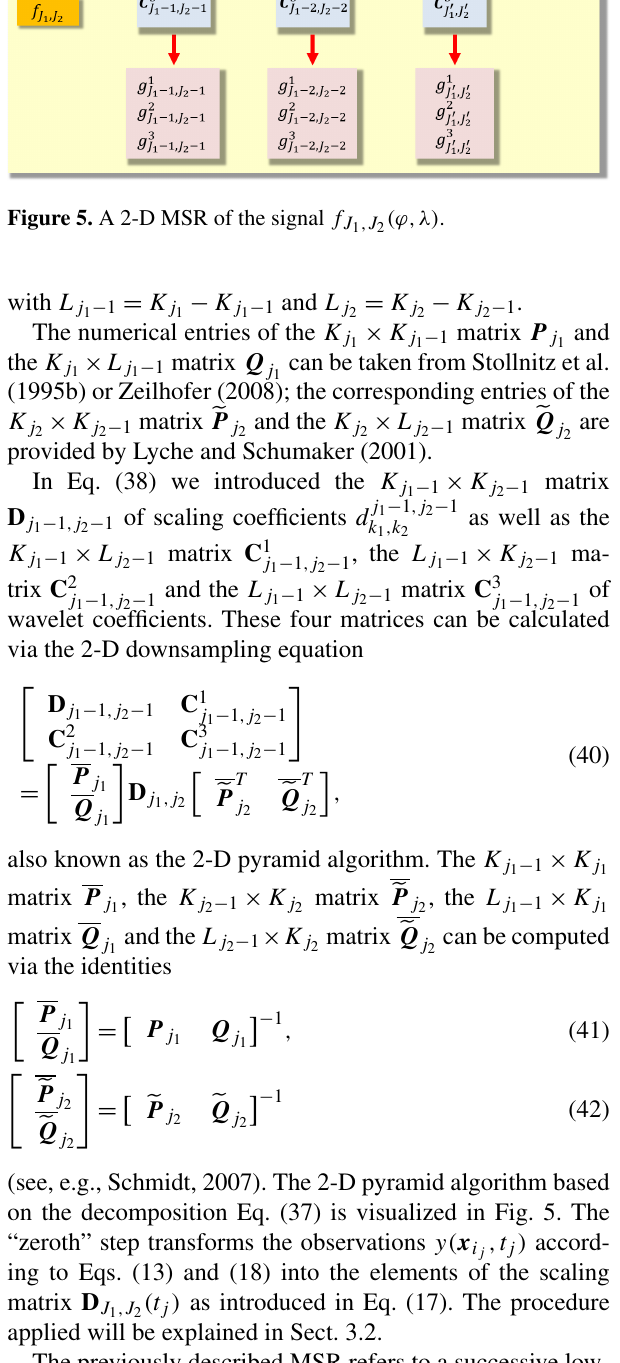
(ϕ,λ) with respect to the 1 ,J 2